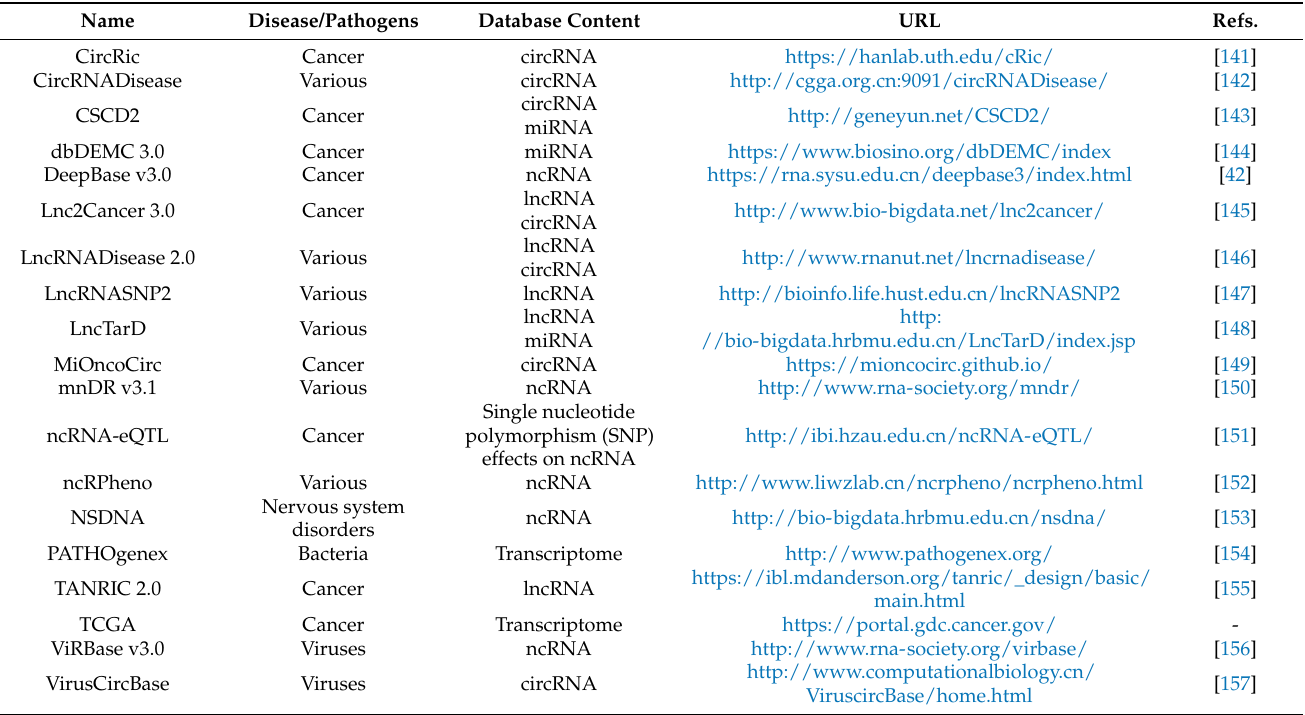
Table 2. A collection of recently developed or updated medically relevant non-coding RNA databases containing NGS generated data. All URLs were accessed on 22 October